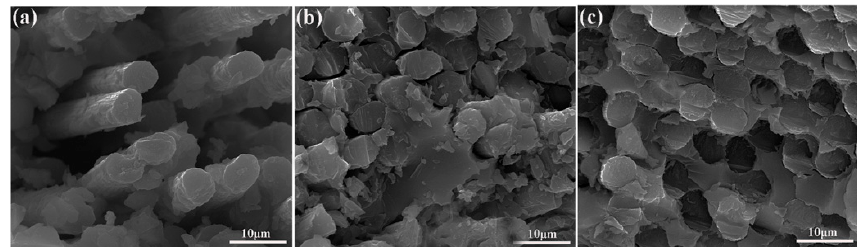
Figure 5. SEM morphologies of the fracture surface of MPSR composites reinforced with ( a ) untreated CF; ( b ) CF / PDA, and ( c ) CF / PDA / SiO 2 .